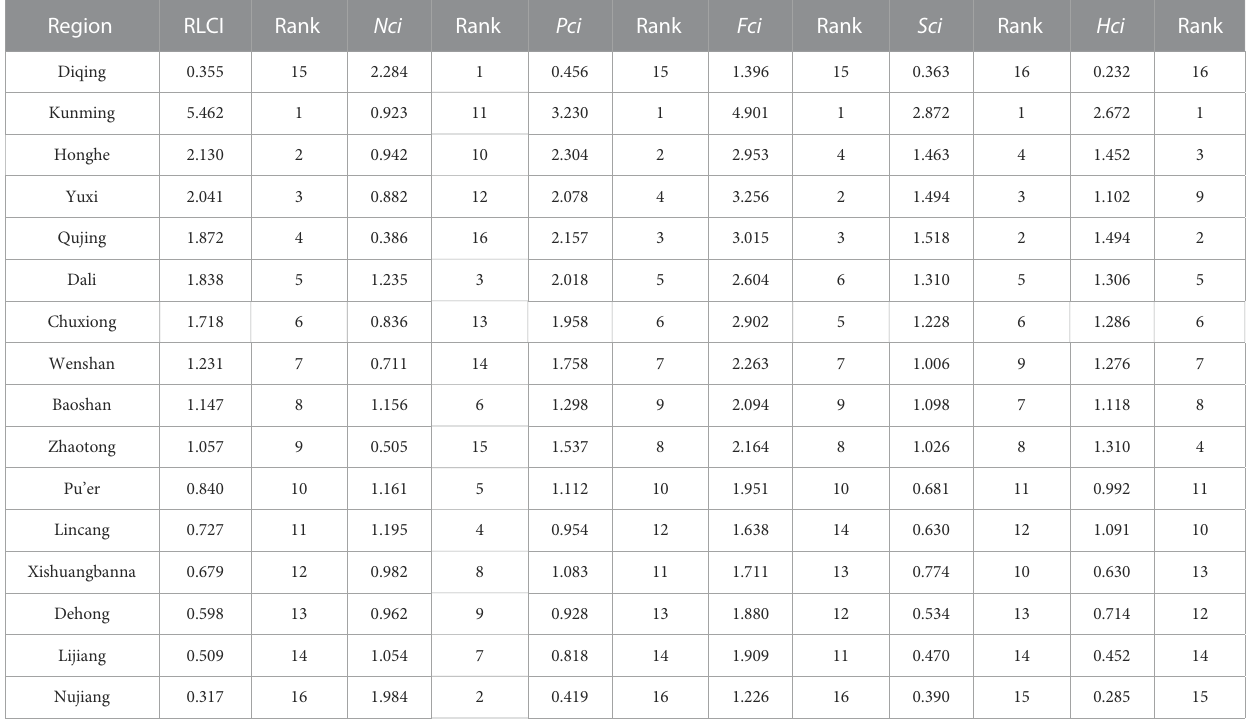
TABLE 3 Regional livelihood capital of 16 regions in Yunnan Province in 2020. Region RLCI Rank Nci Rank Pci Rank Fci Rank Sci Rank Hci